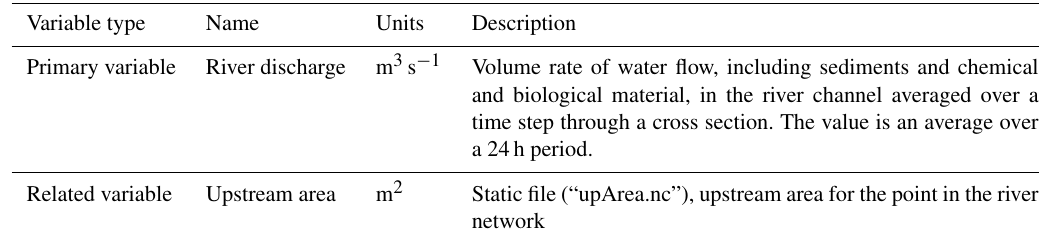
Table 3. Variables available within GloFAS-ERA5 dataset in the C3S Climate Data